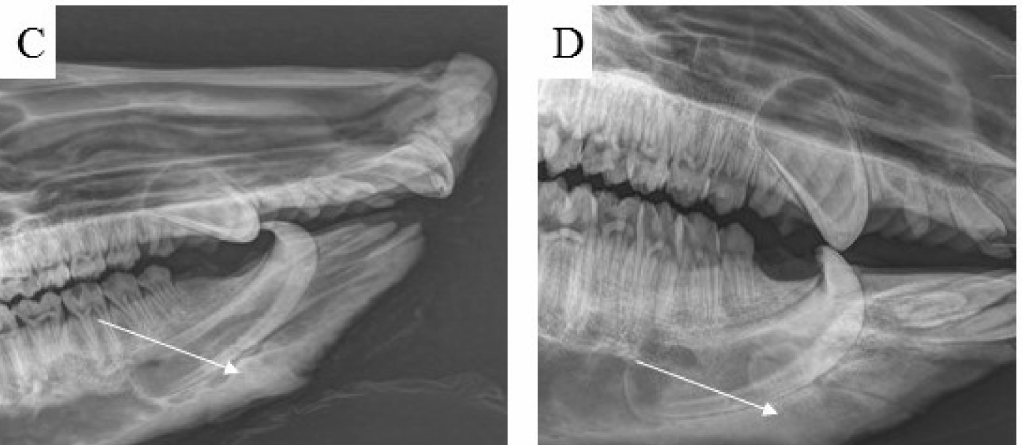
Figure 13. Using standard radiographs, we obtained the required spatial resolution of the right mandible at the level from the first to the second premolar of the evaluated area of the treated part of the cortical bone. For each time period, ( A ) 3 months, ( B ) 4 months, ( C ) 5 months and ( D ) 6 months, post implantation, the mandible defects were filled with newly formed bone tissue, which was completely integrated with the surrounding healthy